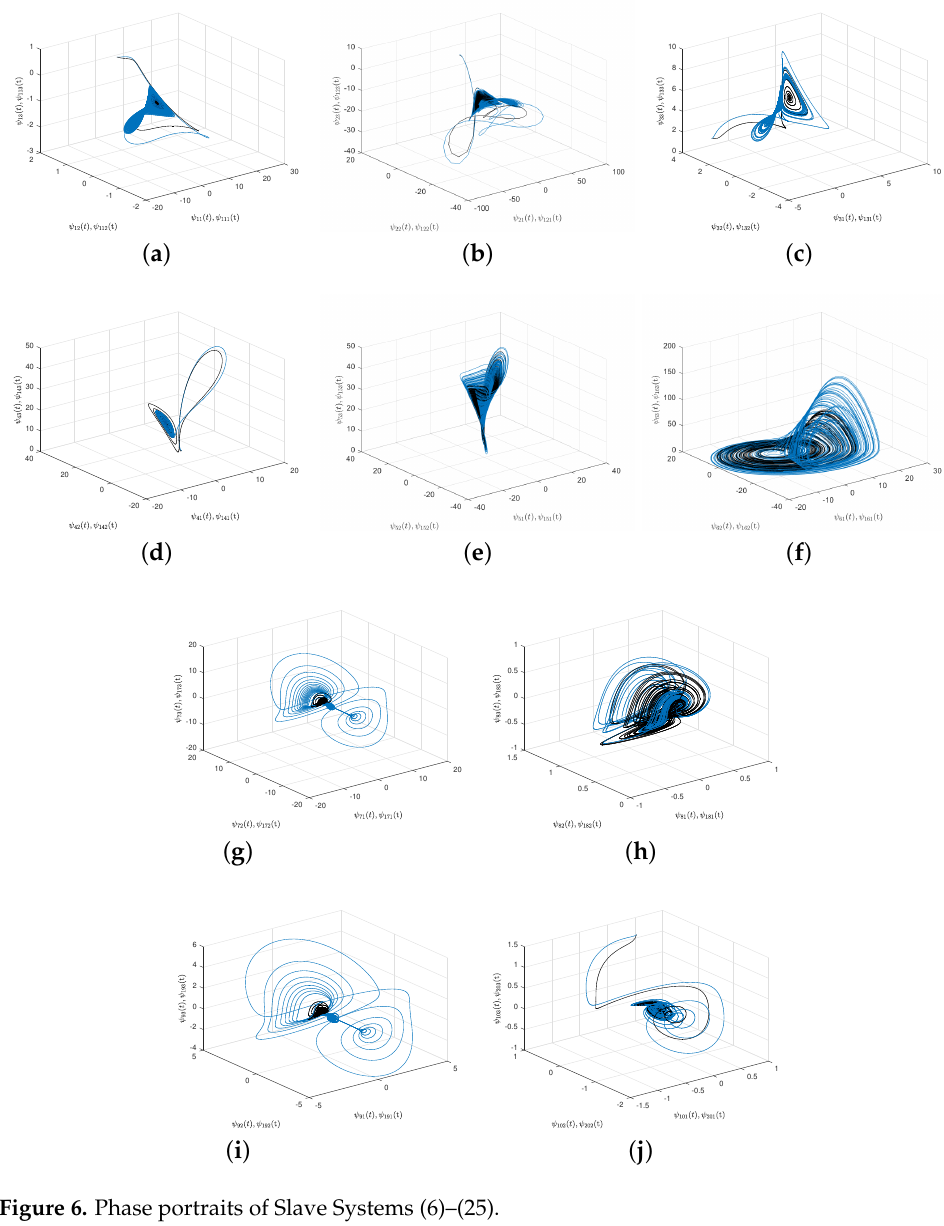
Figure 6. Phase portraits of Slave Systems